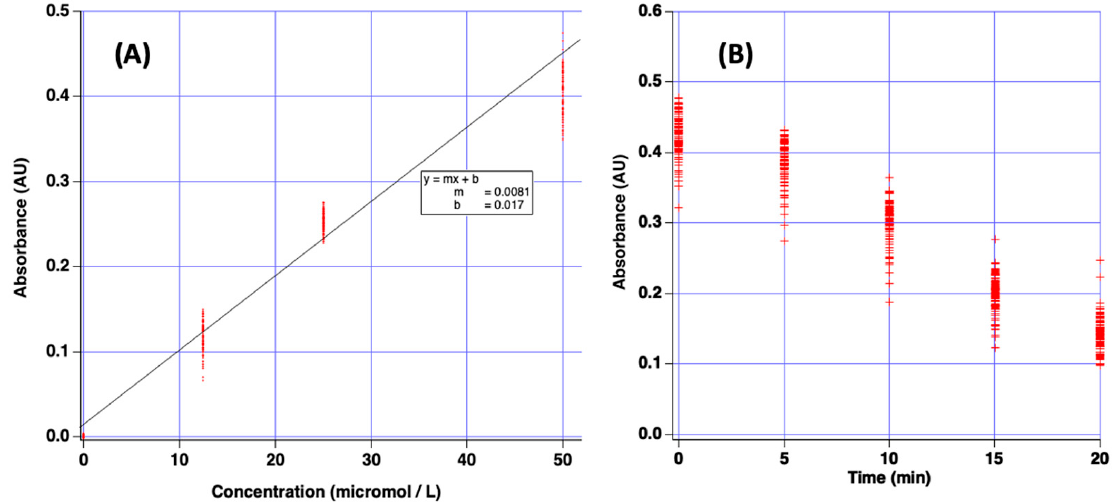
Figure 5. ( A ) Beer’s law plot of absorbance vs. molarity for several concentrations of crystal violet dye as measured with the plate reader and green filter. ( B ) Plot of measured absorbance vs. time for bleaching reaction of crystal violet dye with sodium hydroxide. For both plots, a single data point represents one measurement from a single well of the microplate.